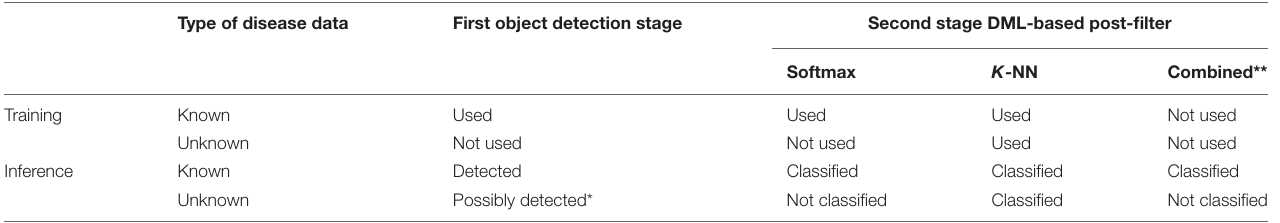
TABLE 1 | Proposed data type scheme for known and unknown disease